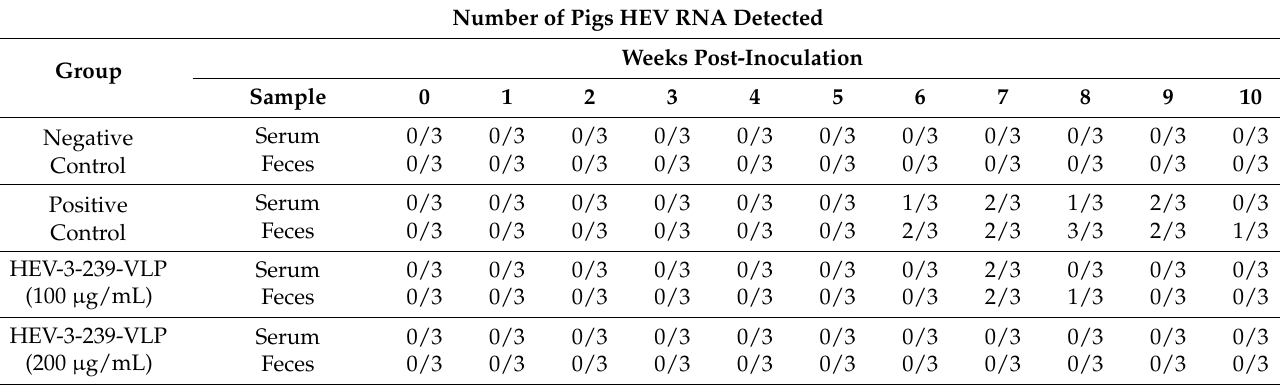
Table 1. The number of pigs with HEV RNA detected in feces and serum collected each week. Number of Pigs HEV RNA Detected